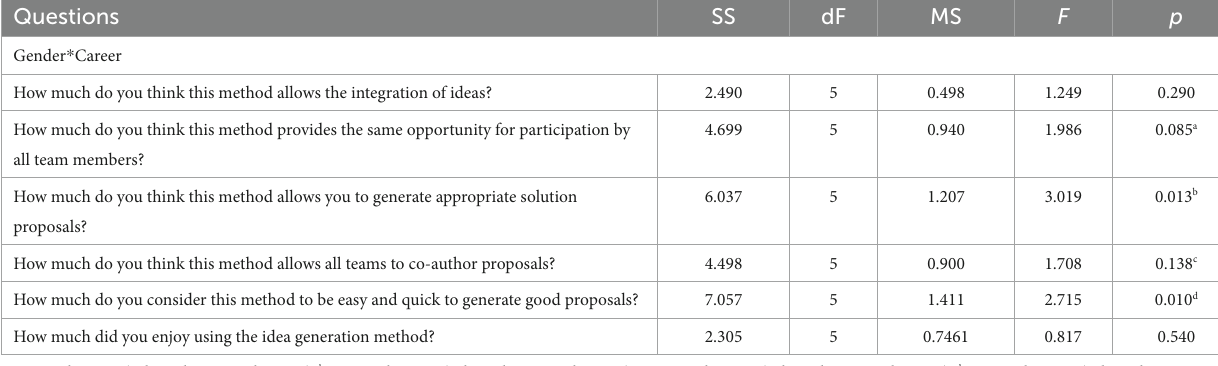
TABLE 7 Statistical result of multivariable ANOVA (MANOVA) for independent variables for questions.